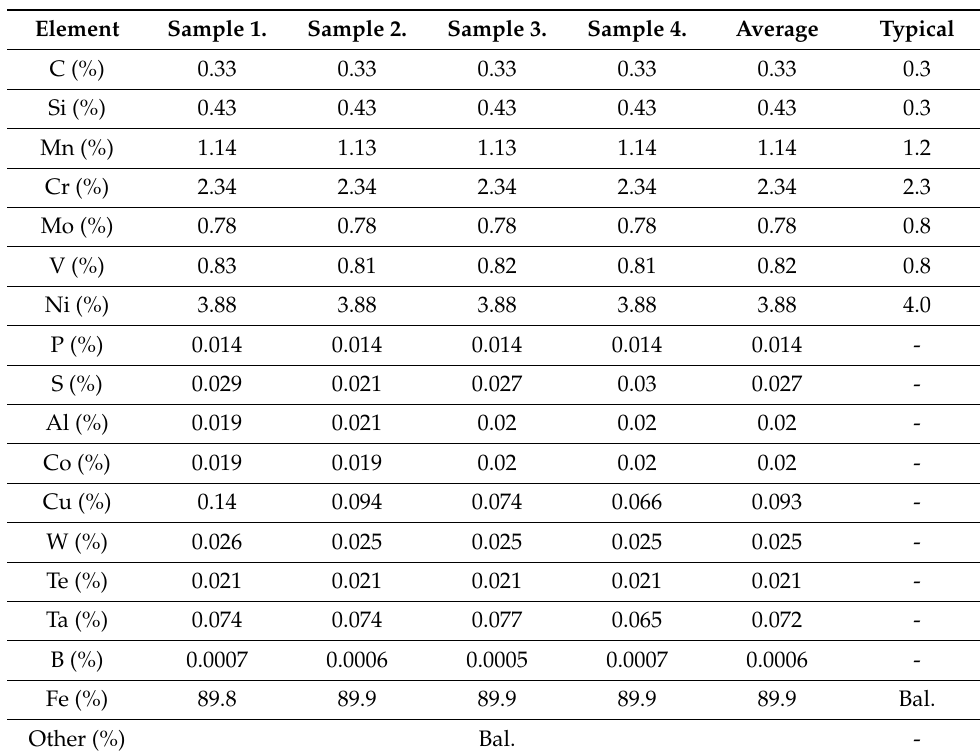
Table 1. Chemical composition of an alloy. Element Sample